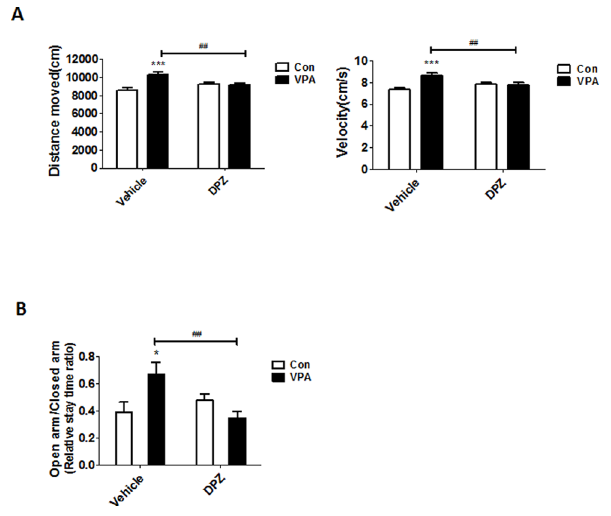
Figure 7. Subchronic treatment of donepezil improved hyper- active and abnormal anxiety behavior in VPA exposed mice. (A) Open field test. Locomotor activity was measured for 20 min using CCD camera-assisted motion tracking apparatus and software (EthoVision 3.1, Noldus information Technology, the Netherlands). Left panel showed total distance moved and right panel showed their velocity (N=12). (B) Elevated plus maze. Data expressed as a ratio of staying time in open arms divided by staying time in closed arms (N=8 for Con and VPA, DPZ:8, N=11 for V + D). Data are expressed as the mean 6 S.E.M. *, ***, p , 0.05, p , 0.001: control mice vs. VPA mice. ## , ### ,